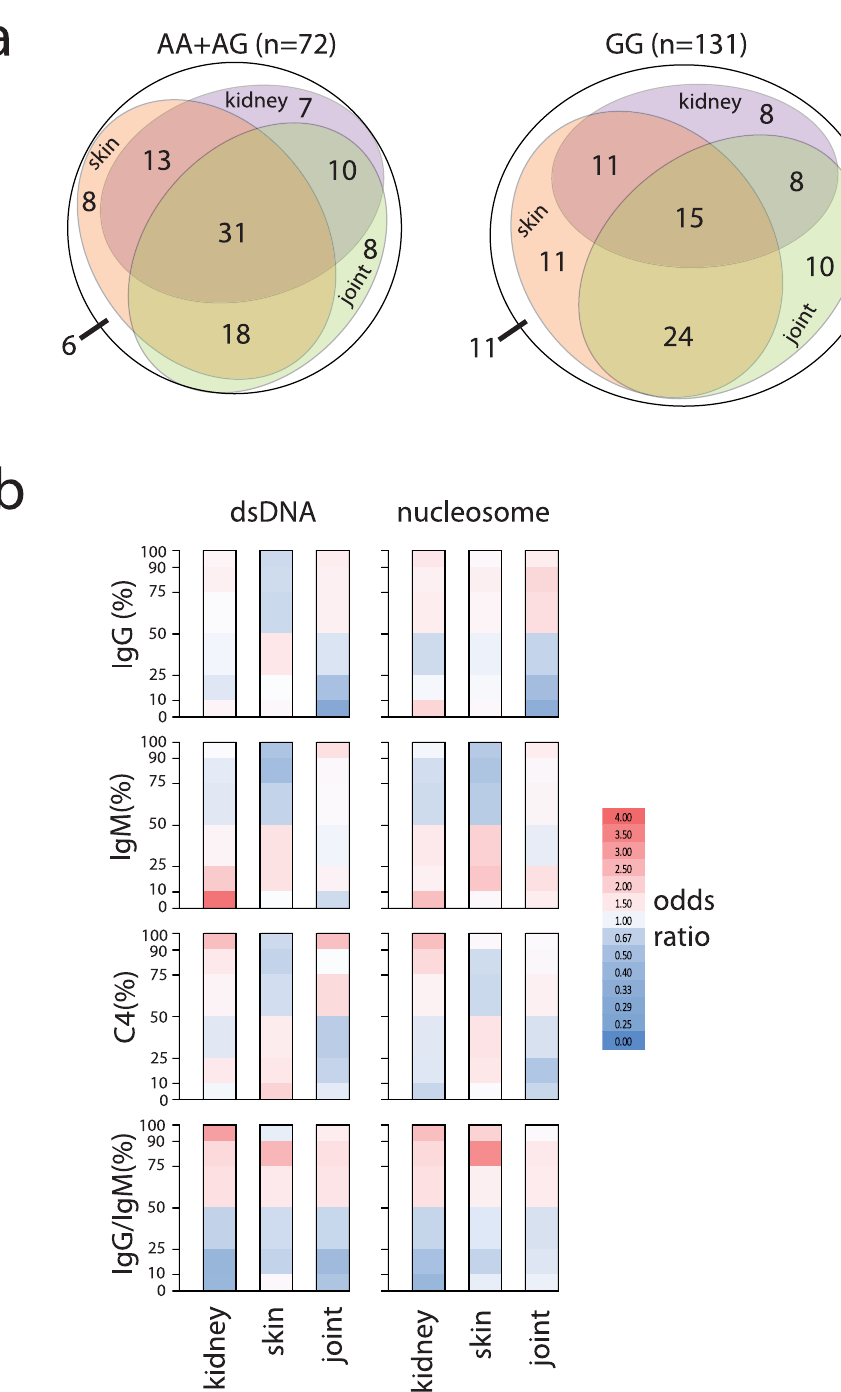
Fig 5. Association of organ involvement with ITGAM genotype and immune complex composition. a . Percentage of the SLE patients with the involvement of the indicated three organs is shown for rs1143679 genotypes. The presence of single, double or triple organ involvement is illustrated by Euler ellipses with areas proportional to the percentages shown. b . Association with organ involvement of the level and composition (IgG, IgM, C4 and IgG/IgM) of immune complexes formed on dsDNA and nucleosome is indicated. Odds ratios for patients falling into the indicated percentile groups (upper 10 th , 25 th , 50 th and lower 10 th , 25 th , 50 th percentiles) for the given measurements are shown. Positive odds ( > 1) are in red, negative odds ( < 1) are in